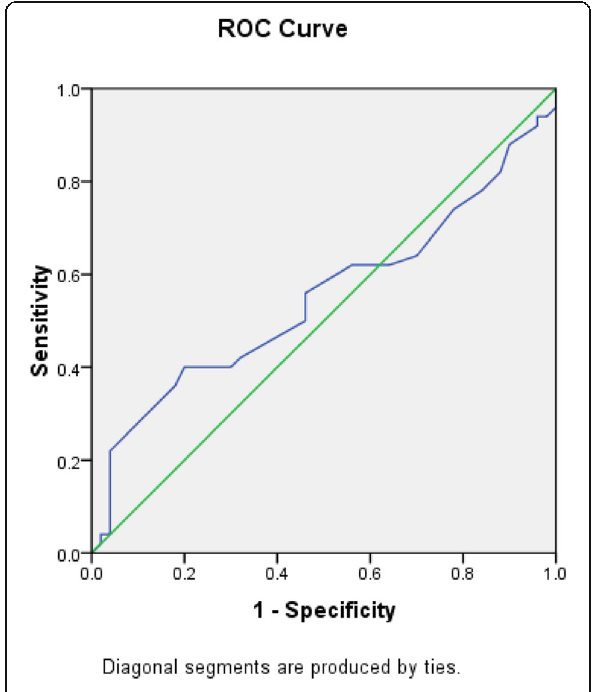
Fig. 3 ROC curve for detection of neurological dysfunction using albumin in all